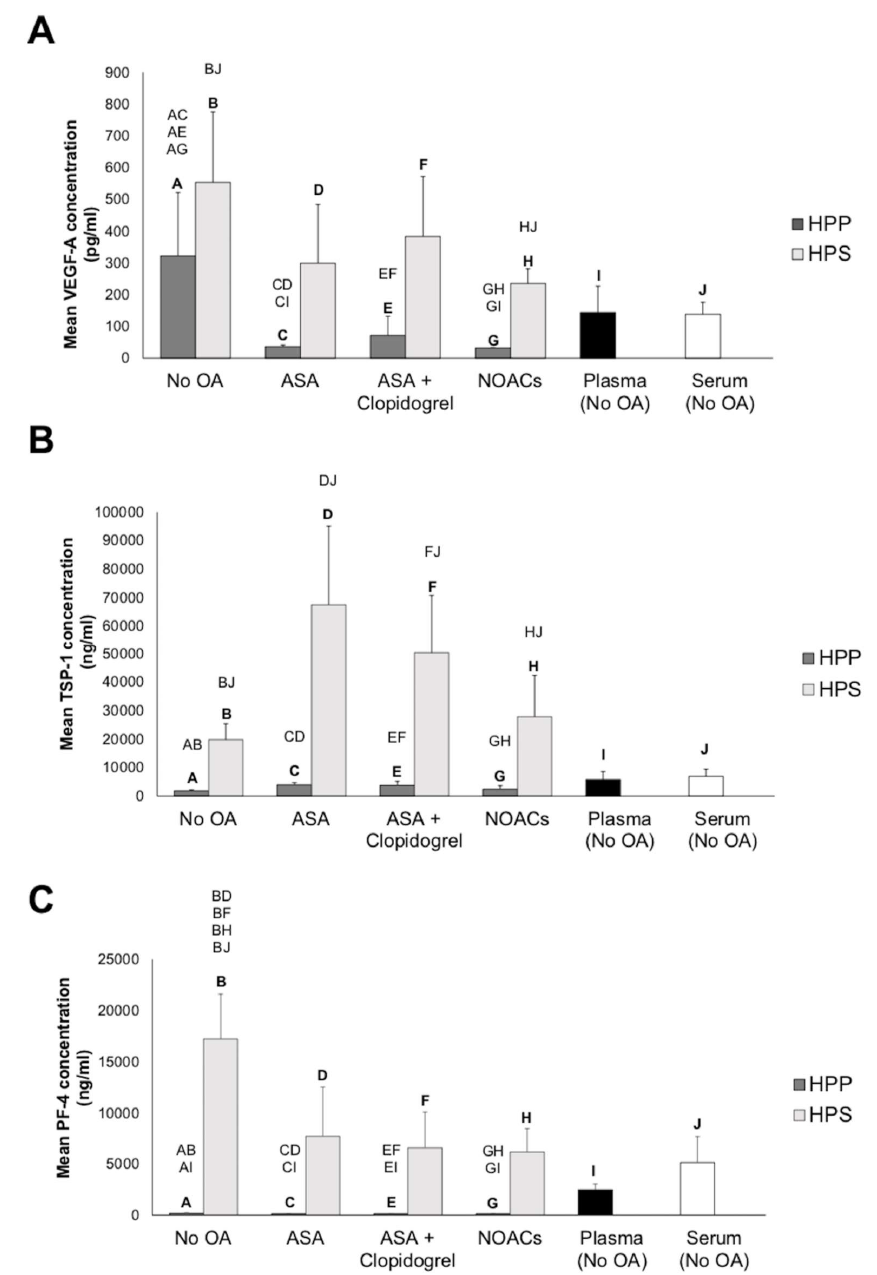
Figure 3. Quantitative analysis of pro- (vascular endothelial growth factor or VEGF) and antiangiogenic (thrombospondin-1 or TSP-1 and platelet factor-4 or PF-4) factor concentrations in blood-derived secretomes obtained with or without oral anticoagulation (OA). Plots showing the concentrations of ( A ) VEGF (pg / mL), ( B ) TSP-1 (ng / mL), and ( C ) PF-4 (ng / mL) in blood-derived secretomes: hypoxia preconditioned plasma (HPP), hypoxia preconditioned serum (HPS), normal plasma, and normal serum. HPP and HPS samples were obtained from subjects that received no oral anticoagulation (OA) or were on treatments with acetylsalicylic acid (ASA), ASA + clopidogrel, or nonvitamin K antagonist oral anticoagulants (NOACs). Capital letter pairs over plots indicate statistical comparisons of the corresponding data points. For all pair comparisons, p < 0.05, unless otherwise indicated. Error bars represent s.d.; number of subjects tested: no OA, n = 5; ASA, n = 8; ASA + clopidogrel, n = 10; NOACs, n = 7; normal plasma (no OA), n = 5; and normal serum (no OA), n = 5. At least one assay well was tested per subject per